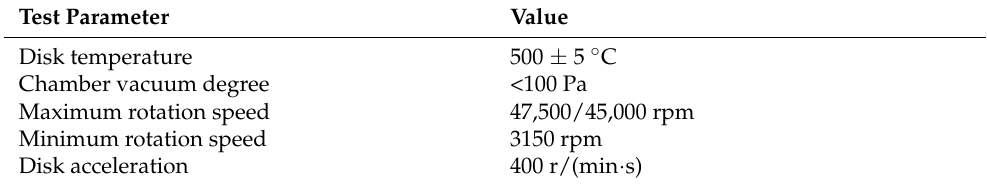
Figure 12. Test load spectrum. Table 4. Experimental details of disc crack propagation.